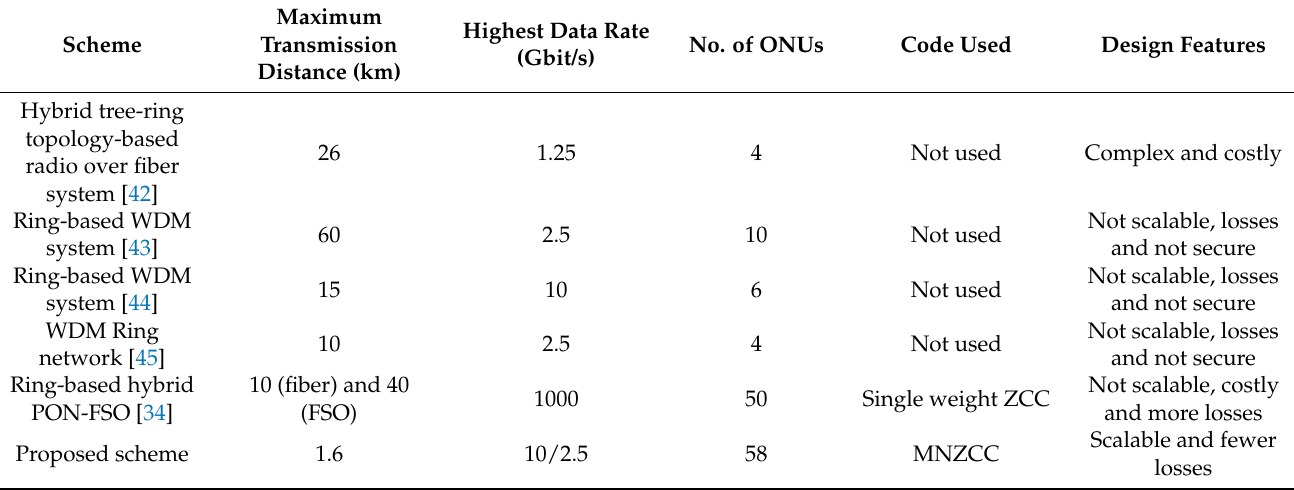
Table 6. Comparisons of proposed scheme with other reported